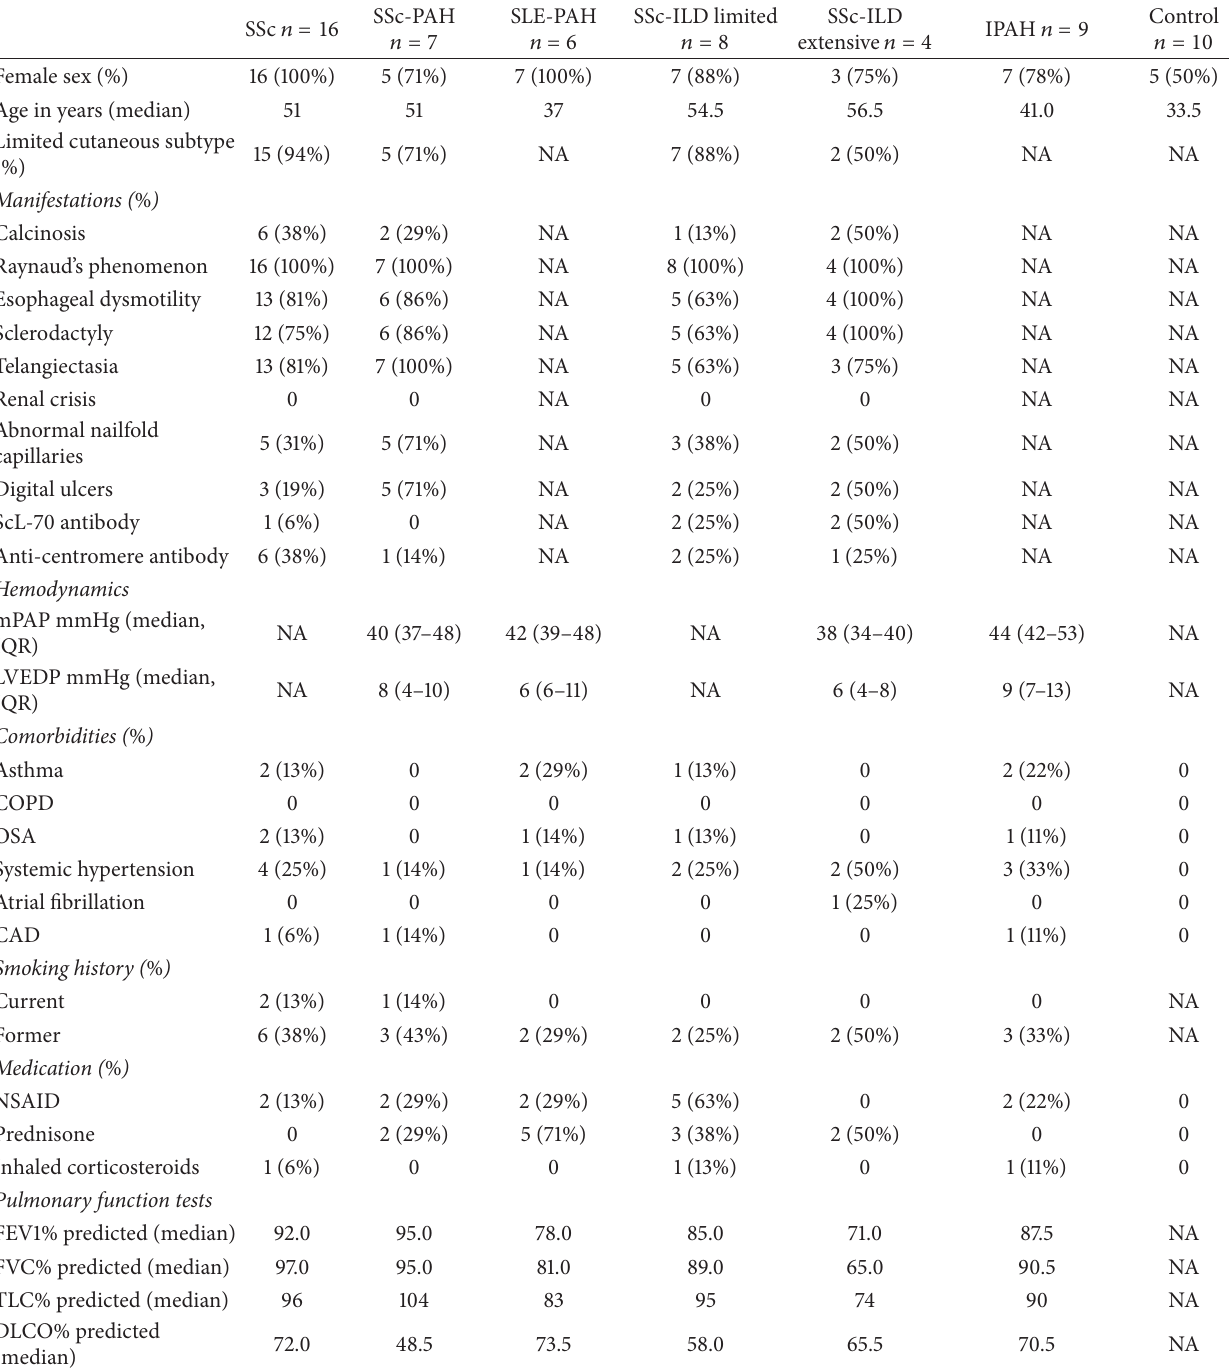
Table 1: Summary of subject